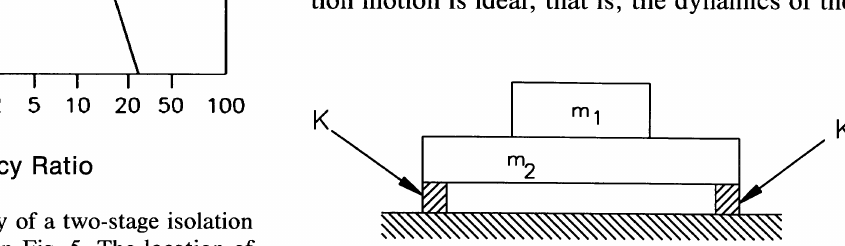
FIGURE 7 Diagram of a piece of equipment (ml) hard mounted to an inertia block